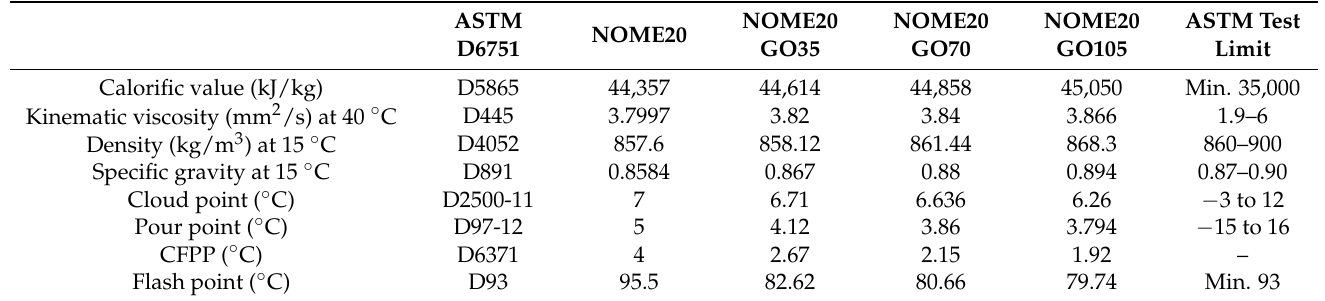
Table 6. Fuel properties of Neem Biodiesel-Diesel-Nano blends by DT method.